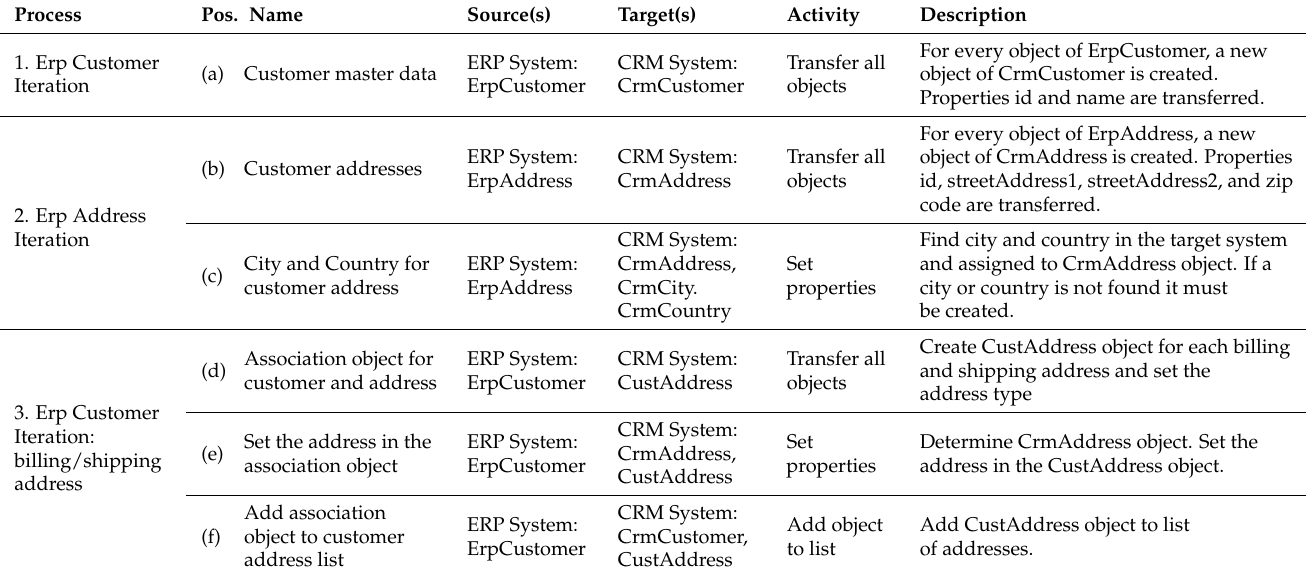
Table 4. Step 6: Analyze, break down, and specify data integration tasks for the